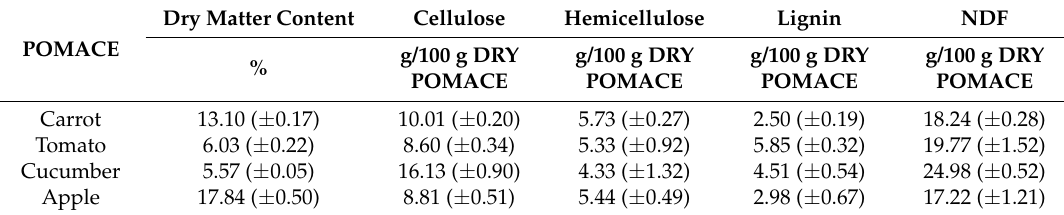
Table 1. Dry matter, neutral detergent fibre (NDF), lignin, hemicellulose, and cellulose content in